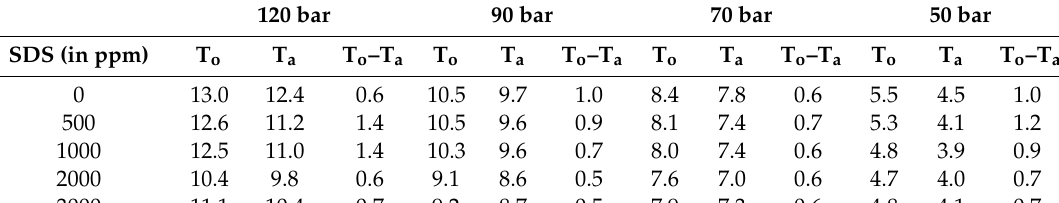
Table 4. Calculation of T 0 ( ◦ C), T a ( ◦ C), and T 0 − T a ( ◦ C) for fresh SDS Solution.